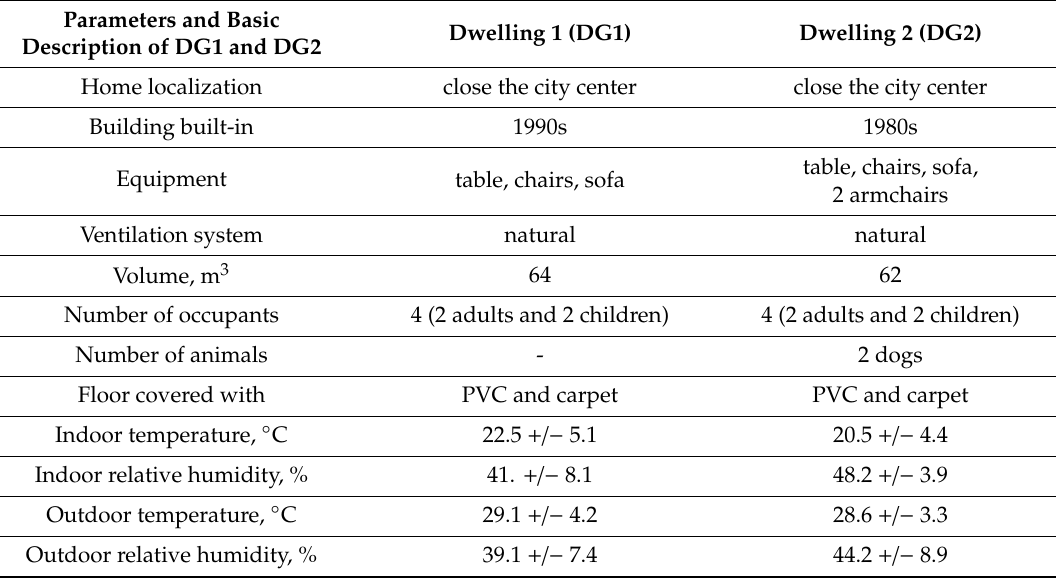
Table 1. Environmental parameters (mean +/ − standard deviation), and a basic description of